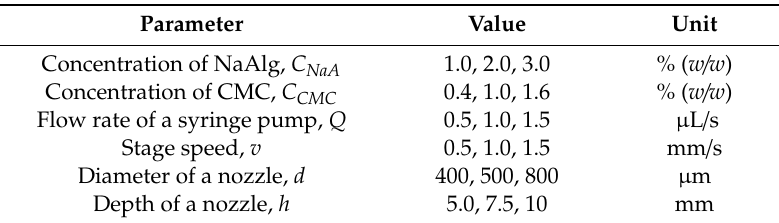
Table 2. Value of the all parameters.